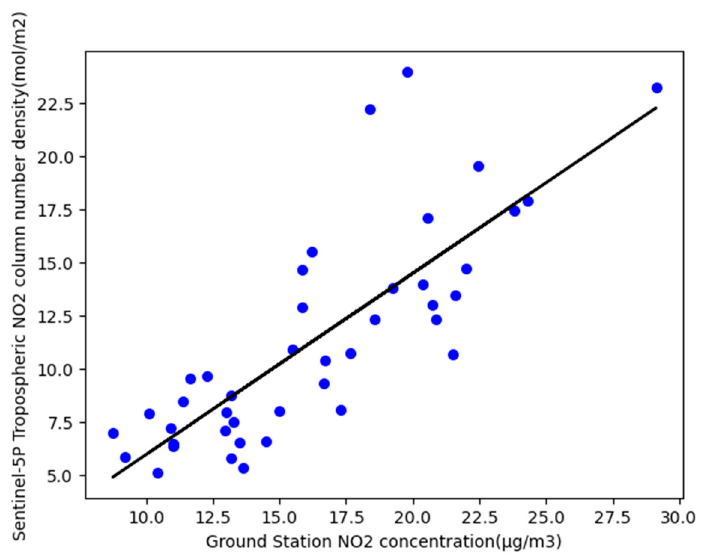
Figure 8. The correlation between the ground station NO 2 concentration and Satellite observed tropospheric NO 2 column number density. The analysis was based on 42 monthly average data from July 2018 to December 2021 as the NO 2 column was released by Sentinel 5P in July 2018. The ground monitor unit was multiplied by 10 5 in the figure.